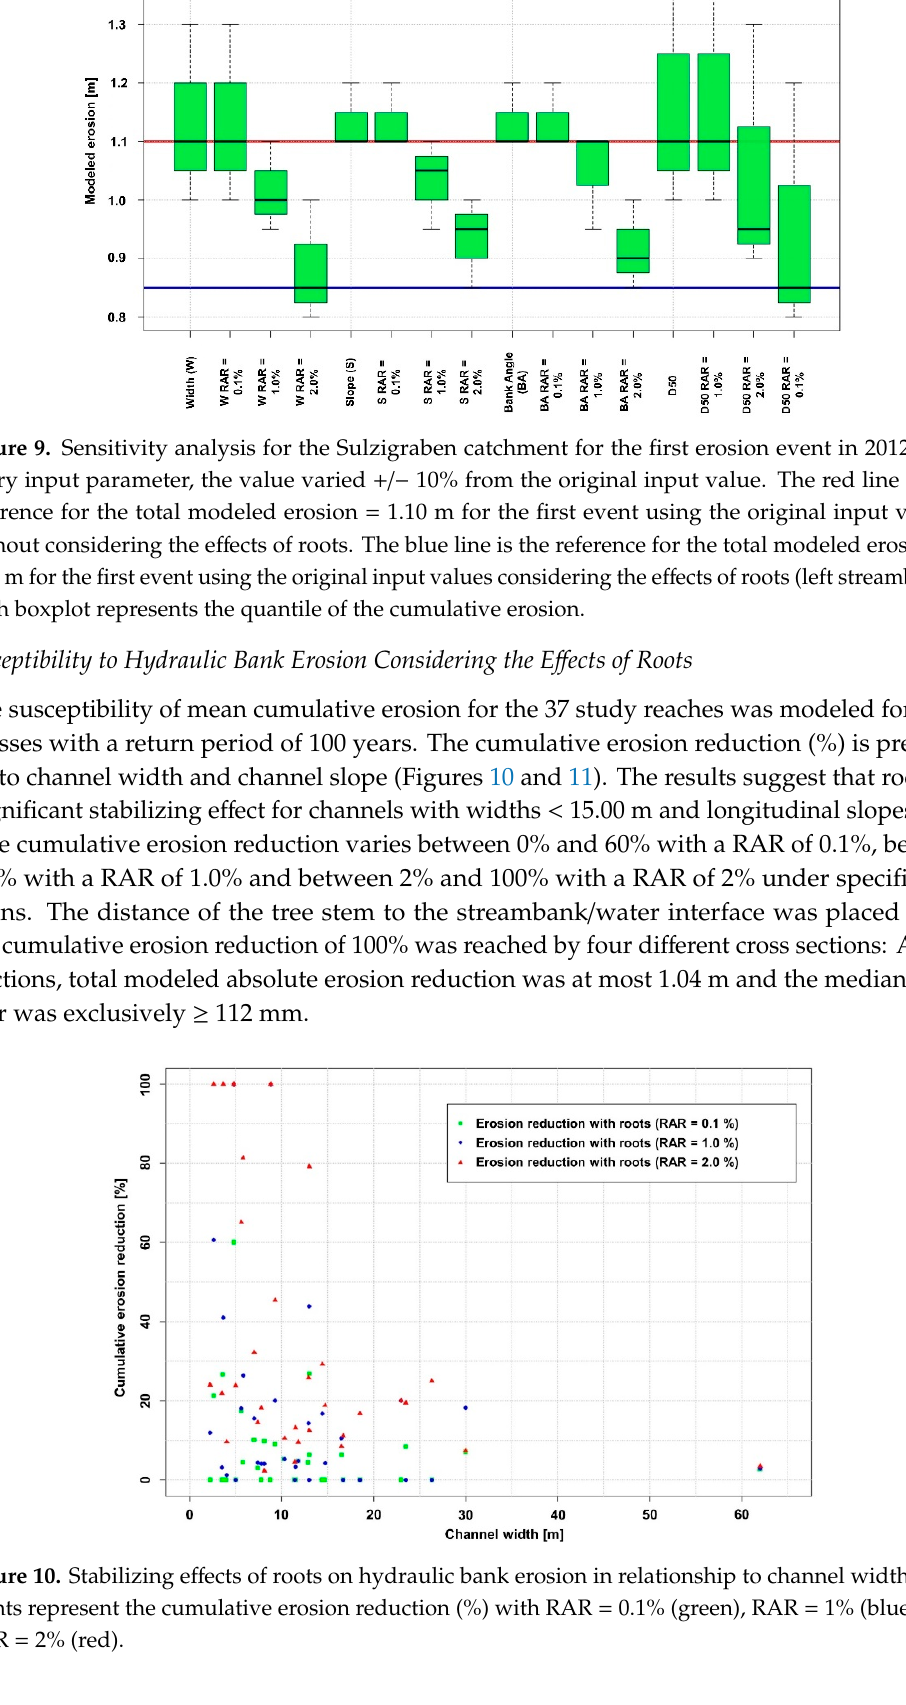
Figure 8. Sensitivity analysis representing event 12 for the Thur River catchment. For every input parameter, the value varied +/ − 10% from the original input value. The red line is the reference for the modeled erosion = 9.18 m using the original input values. Each boxplot represents the quantile of the cumulative erosion.